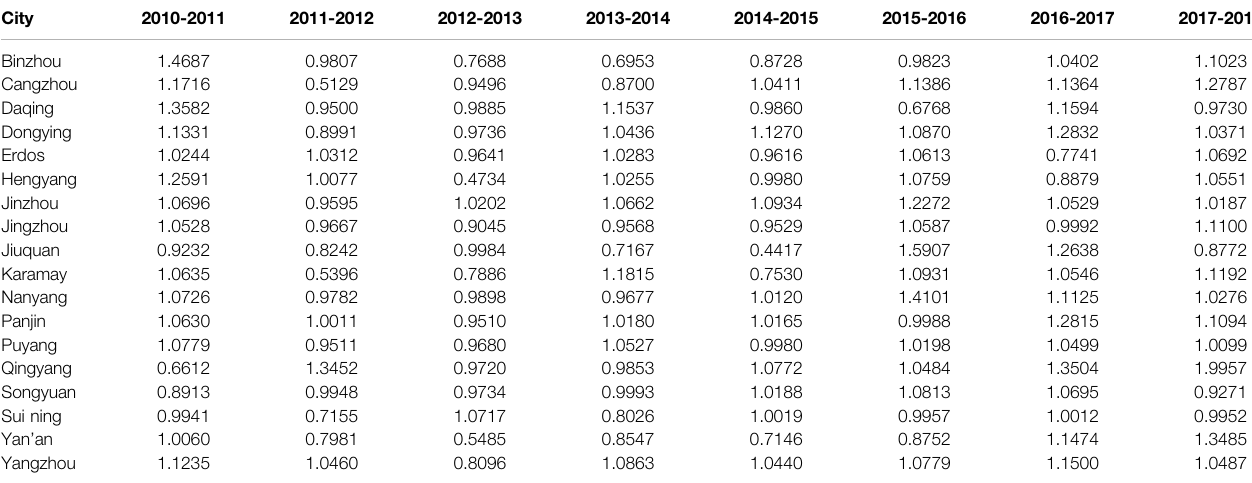
TABLE 5 | Evaluation results of green dynamic growth ef fi ciency.